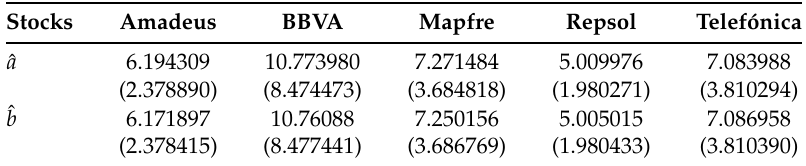
Table 2. Maximum likelihood estimates for the skewed t model of Type 1, standardized data. Standard errors are in